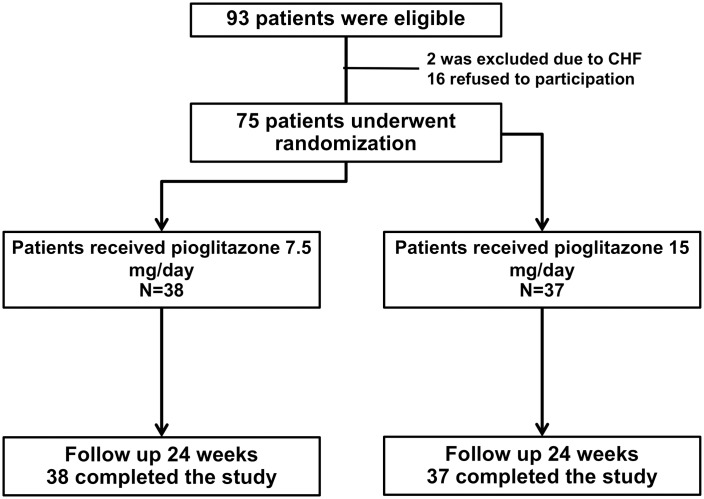
Flow chart study.